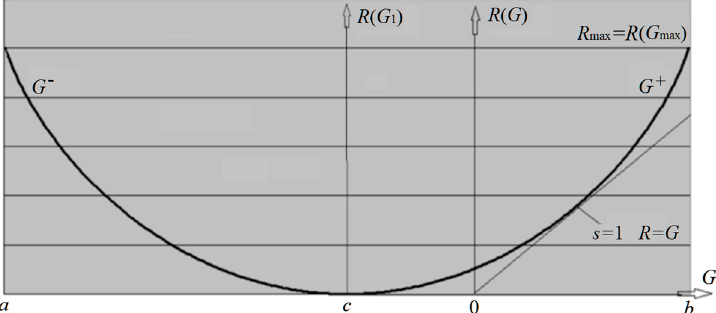
Figure 5. The rate-verisimilitude function R ( G ) for binary communication. For any R ( G ) function, there is a point where R ( G ) = G .